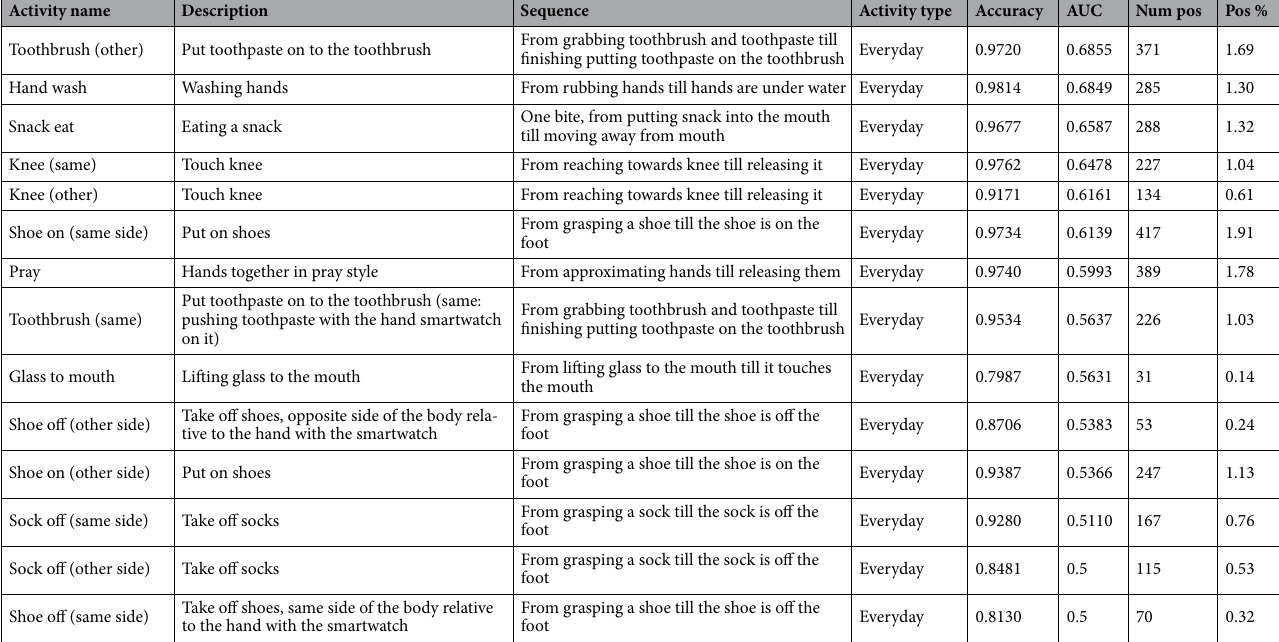
Table 3. The Budapest activity test battery (BATB) and performance of the machine learning methods. The table was sorted by AUC with the highest recognition figures at the top. Num pos is the number of occurrences of a given activity in the